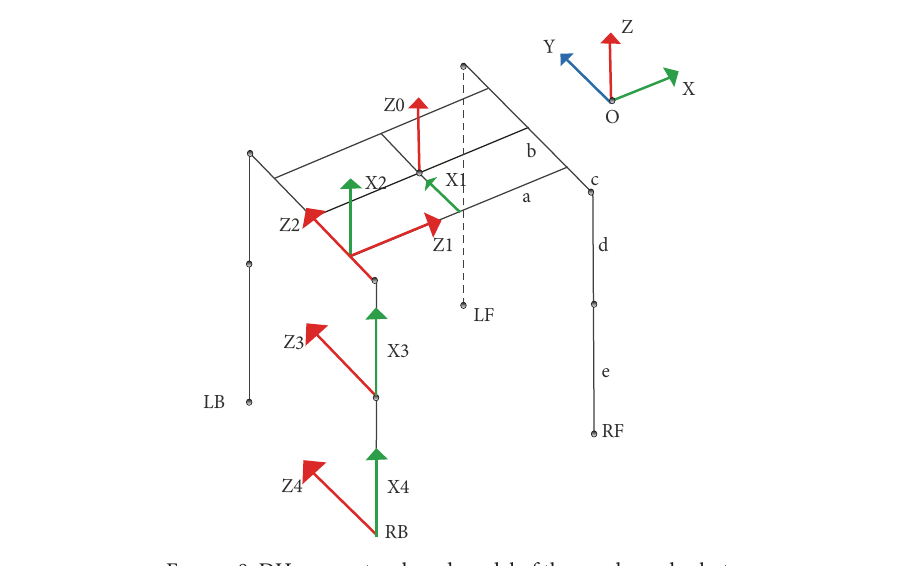
Figure 8: DH parameters based model of the quadruped robot. Table 3: The DH parameters for the left